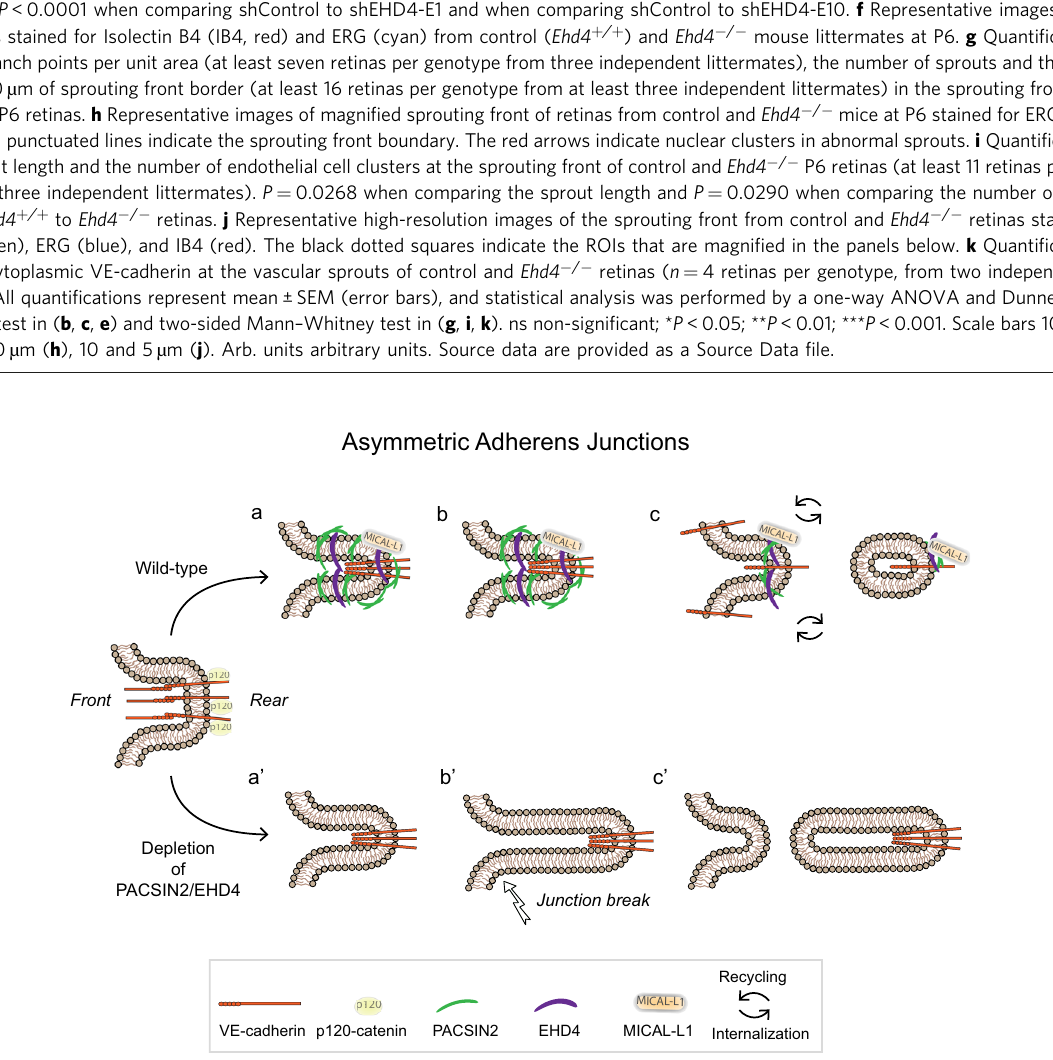
Fig. 8 Schematic representation of how the PACSIN2/EHD4/MICAL-L1 complex controls traf fi cking of VE-cadherin at asymmetric junctions. Asymmetric adherens junctions are formed between leader and follower cells in migrating endothelial collectives. The F-BAR protein PACSIN2 as well as the traf fi cking and recycling proteins EHD4 and MICAL-L1 are recruited to the rear of asymmetric junctions ( a ). The PACSIN2/EHD4/MICAL-L1 complex enables the proper traf fi cking of VE-cadherin at the junction rear, ensuring gradual turnover of asymmetric junctions in support of collective migration ( b , c ). In the absence of PACSIN2 or EHD4, this VE-cadherin traf fi cking systems fails, leading to asymmetric junction elongation and eventually ruptures ( a ′ , b ′ ), resulting in an accumulation of internalized VE-cadherin levels ( c ′ Statistics . All data were analyzed using GraphPad Prism software. The graph error JACOP. The number of VE-cadherin-positive vesicles in pulse-chase experiments bars represent mean± SEM. Sample size and experimental replicates are indicated was quanti fi ed as the number of vesicles detected in the cytoplasm using the Find in the fi gure legends. We used the nonparametric two-sided Mann − Whitney ’ s test, Maxima (prominence = 15000) and Analyze Particle (size = 0.1 – 1.5; circularity = the parametric Student ’ s t test, one-way ANOVA or Kruskal – Wallis with Dunnett ’ s 0.50 – 1.00) tools in ImageJ. Asymmetric AJs maximal length and lifetime during multiple comparison test, and a paired nonparametric Wilcoxon test. We desig- wound closure were quanti fi ed by manually tracking remodeling AJs in the fi rst nated P values in fi gures as: ns not signi fi cant; * P <0.05; ** P < 0.01; *** P < 0.001. two rows of migrating cells from the moment of their formation. The intensity of Western Blot bands was measured by the Gel Analyzer plugin in ImageJ.